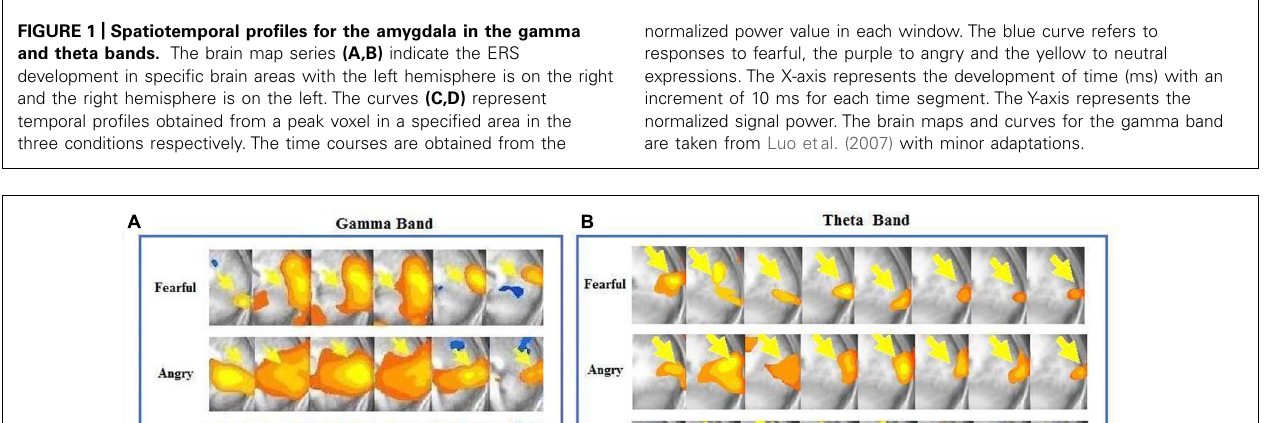
normalized power value in each window. The blue curve refers to responses to fearful, the purple to angry and the yellow to neutral expressions. The X-axis represents the development of time (ms) with an increment of 10 ms for each time segment. The Y-axis represents the normalized signal power. The brain maps and curves for the gamma band are taken from Luo etal. (2007) with minor adaptations.